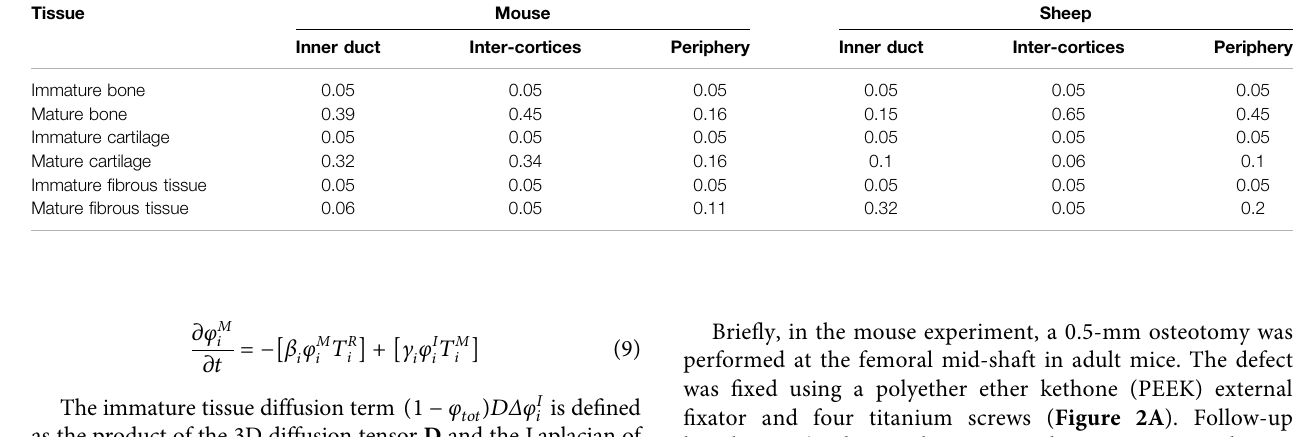
TABLE 3 | Initial tissue fractions in the regions of interest, computed from the quanti fi cation of the 14-day and 6-week histology data for mouse and sheep, respectively; the immature tissue fractions were all assumed to be equal to 5% initially. Tissue Mouse Sheep Inner duct Inter-cortices Periphery Inner duct Inter-cortices Periphery Immature